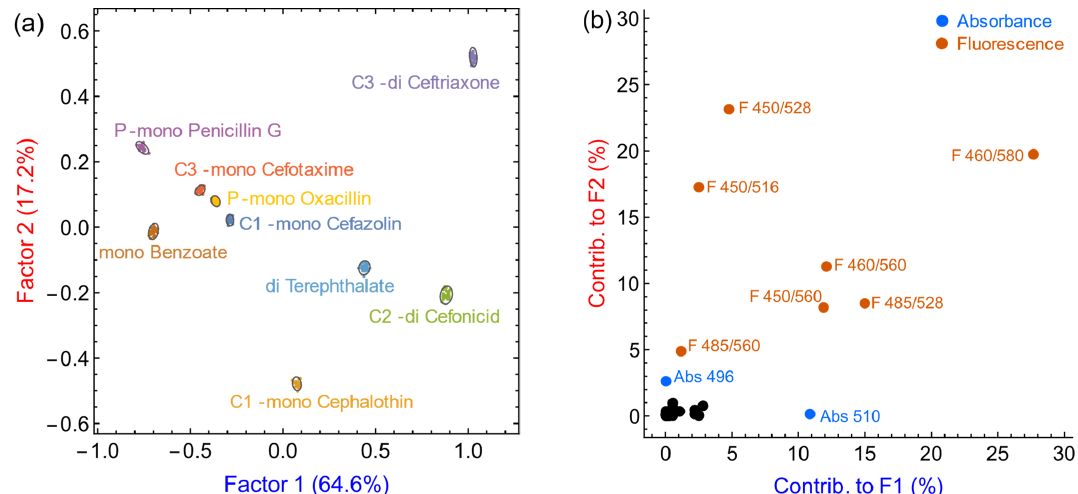
Figure 8. LDA results to estimate the limit of discrimination of nine analytes (two penicillins, five cephalosporins and two reference carboxylates) using [calcein•PAMAM] sensor. ( a ) Scores plot; ( b ) loadings plot. Abs: absorbance, F: fluorescence emission λ ex / λ em . The black points correspond to instrumental measurements with very low contributions to both LDA factors; these were mostly fluorescence anisotropy measurements that were later removed in further analyses. Analyte solutions were prepared at pH 10 and then brought back to pH 7.4 for β -lactam ring hydrolysis. Measurements of absorbance at UV range and dye clusters were removed for better separation of analyte clusters. [calcein] = 6.36 μ M, [PAMAM G5] = 2.13 μ M, [analytes] = 1.0 mM. Performed in 50 mM aqueous HEPES buffer, T = 25 °C.